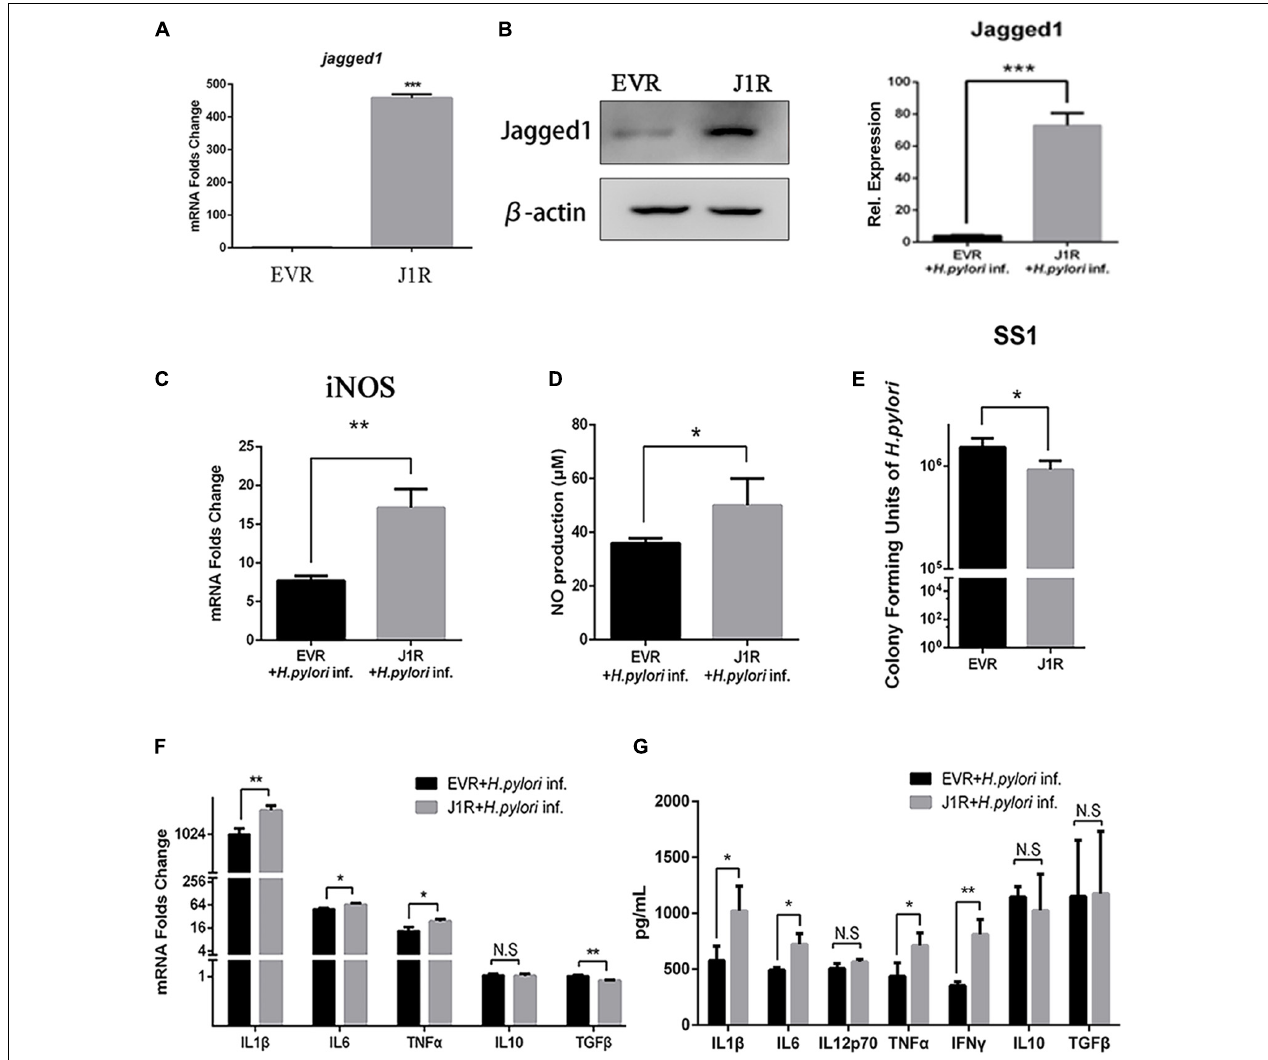
FIGURE 5 | Overexpression of Jagged1 facilitates the secretion of pro-inflammation mediators and bactericidal activity of RAW264.7 cells against H. pylori . (A,B) The Jagged1-pCMV-Tag4 was transfected into RAW264.7 (J1R) cells, and empty vector transfection was conducted in the control (EVR). Then, the total RNA and total proteins were extracted to verify mRNA and protein expression levels of Jagged1 by qPCR and Western blot analyses. The exposed bands were analyzed by Gel-pro Software by outputting the value of the (IOD). (C) qPCR was performed to assess the mRNA expression level of iNOS. (D) Griess was performed to assess the production of NO in the supernatant. (E) J1R was co-cultured with H. pylori (MOI = 50) for 12 h. EVR was used as control for J1R. Then, H. pylori in the supernatant was harvested and cultured for 7 days and plated to calculate the number of CFU of H. pylori . (F) qPCR was performed to assess the mRNA expression levels of pro-inflammatory cytokines IL-1 β , IL-6, and TNF- α and anti-inflammatory cytokines IL-10 and TGF- β . (G) ELISA was performed to assess the protein expression level of pro-inflammatory cytokines IL-1 β , IL-6, IL-12p70, TNF- α , and IFN- γ and anti-inflammatory cytokines IL-10 and TGF- β in the supernatant. β -actin was used as internal control. Data are presented as the mean ± SD of three independent experiments * p < 0.05, ** p < 0.01; N.S. represents no significant difference.